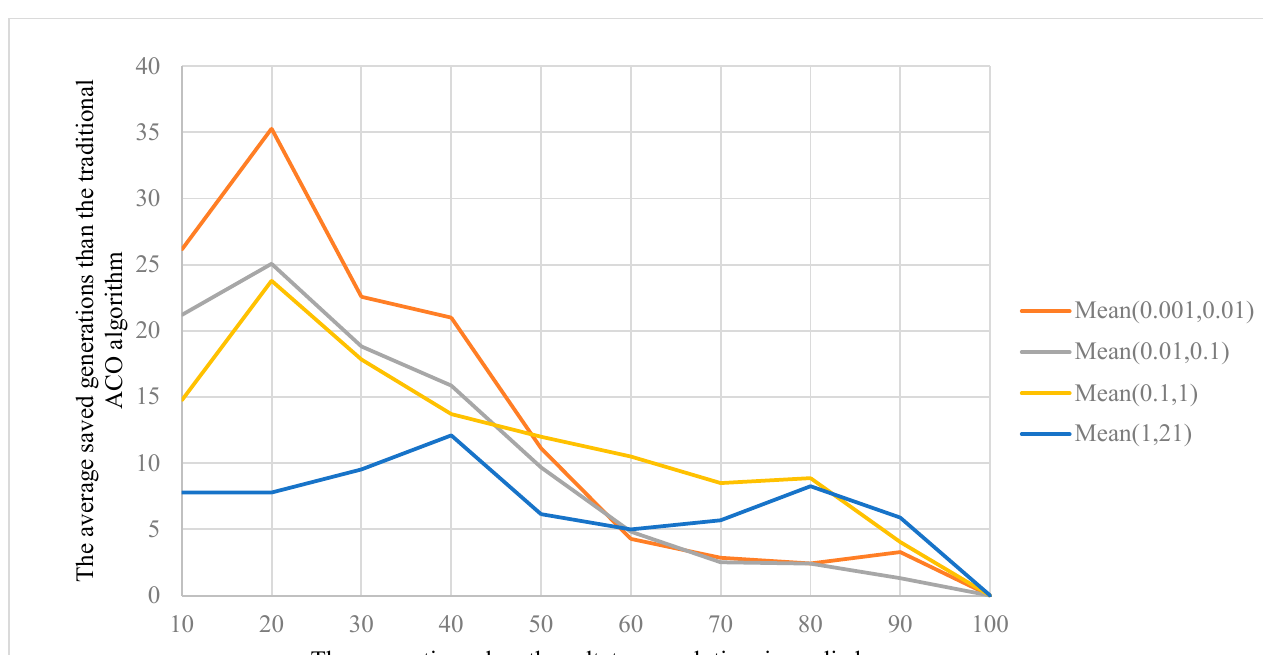
Figure 12. The classified statistics of the extreme influence of path distance.